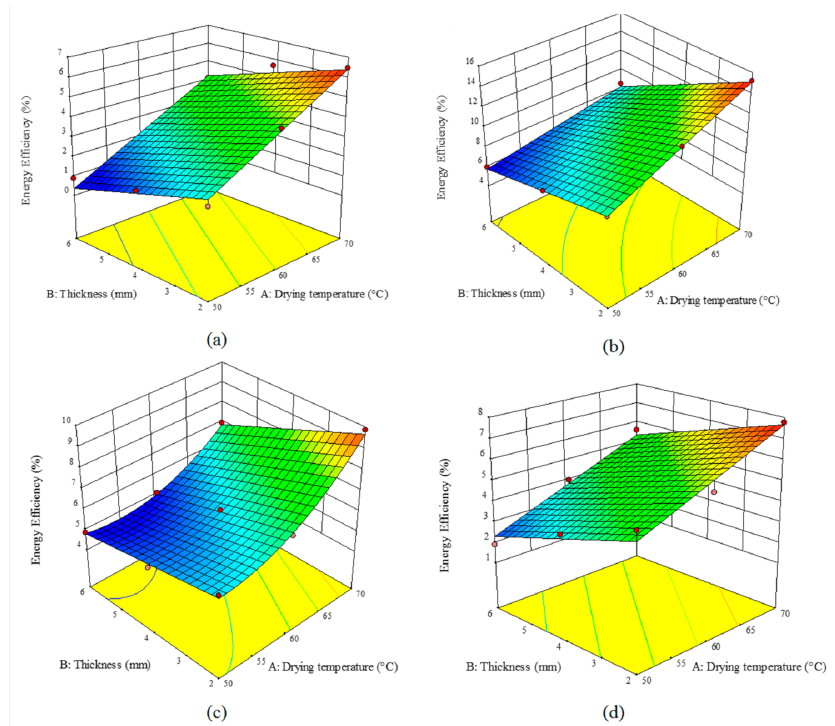
Figure 4. Effect of the drying temperature and sample thickness on the energy efficiency (%) of an HCIR dryer with various pretreatments ( a ) control, ( b ) microwave, ( c ) ultrasound, and ( d ) blanching.